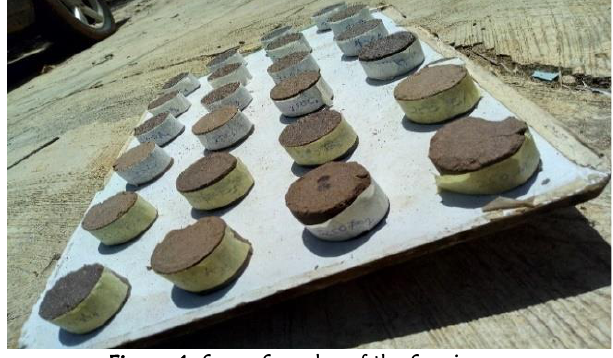
Figure 4: Some Samples of the